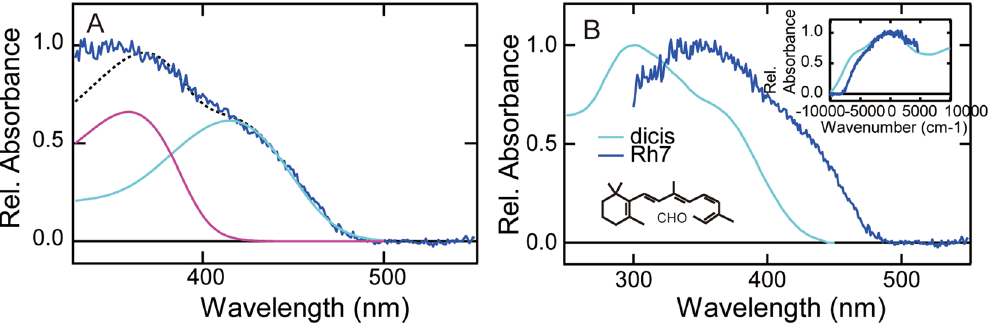
Figure 6. Spectral component analysis of Rh7. ( A ) Fitting of absorption spectrum of Rh7-Cap (blue curve) with two template spectra modeled by the Lamb and Govardovskii method (dashed black curve). λ max of two template spectra are 415 nm (cyan curve) and 360 nm (magenta curve). ( B ) Comparison of absorption spectra between purified Rh7-Cap (blue curve) and 11,13- dicis -retinal in EPA (cyan curve). The structure of 11,13- dicis -retinal is shown in the graph. Inset shows the absorption spectra of Rh7-Cap and 11,13- dicis -retinal plotted against the